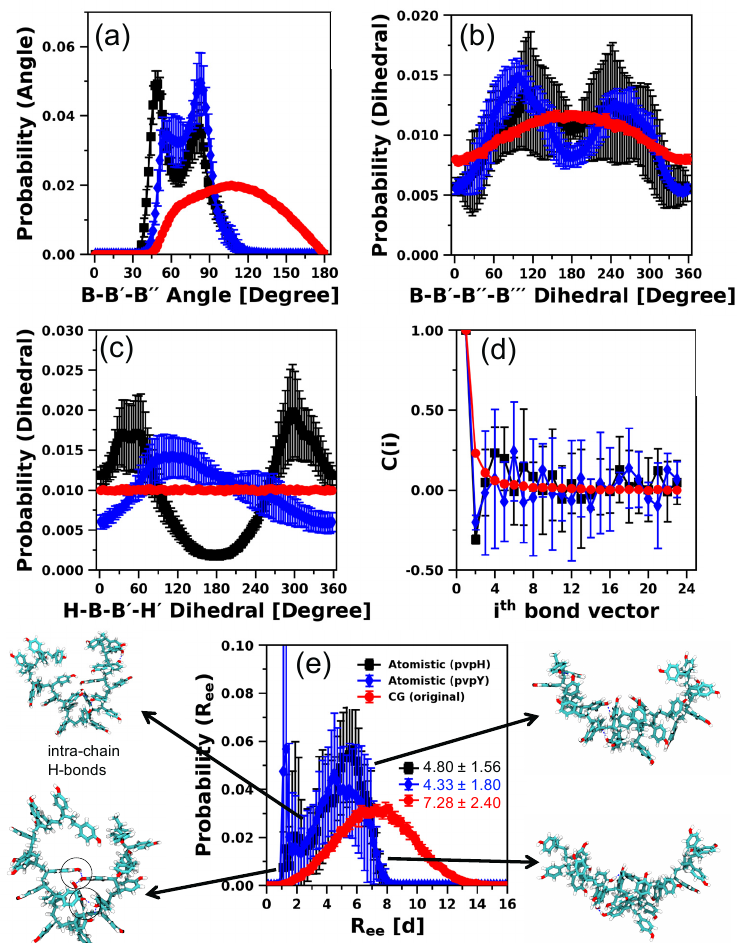
Figure 3. Comparison of distributions of ( a ) B–B´–B´´ angle, ( b ) B–B´–B´´–B´´´ dihedral, ( c ) H–B–B´–H´ dihedral, ( d ) bond-vector autocorrelation functions, and ( e ) R ee distance (with ensemble average values in reduced units (d)), with atomistic simulation snapshots of pvpH chains included at various R ee , obtained from atomistic simulations of 24-mer pvpH and pvpY chains and CG 24-mer chain simulations using the generic CG model of Kulshreshtha et al. [109] (denoted as “original” CG model). The legend in part ( e ) is applicable for all parts. The standard deviations are computed from the means of 5 independent trials for atomistic simulations and 10 independent trials for CG simulations and the lines joining the symbols in parts ( a – c , e ) are drawn to guide the eye.